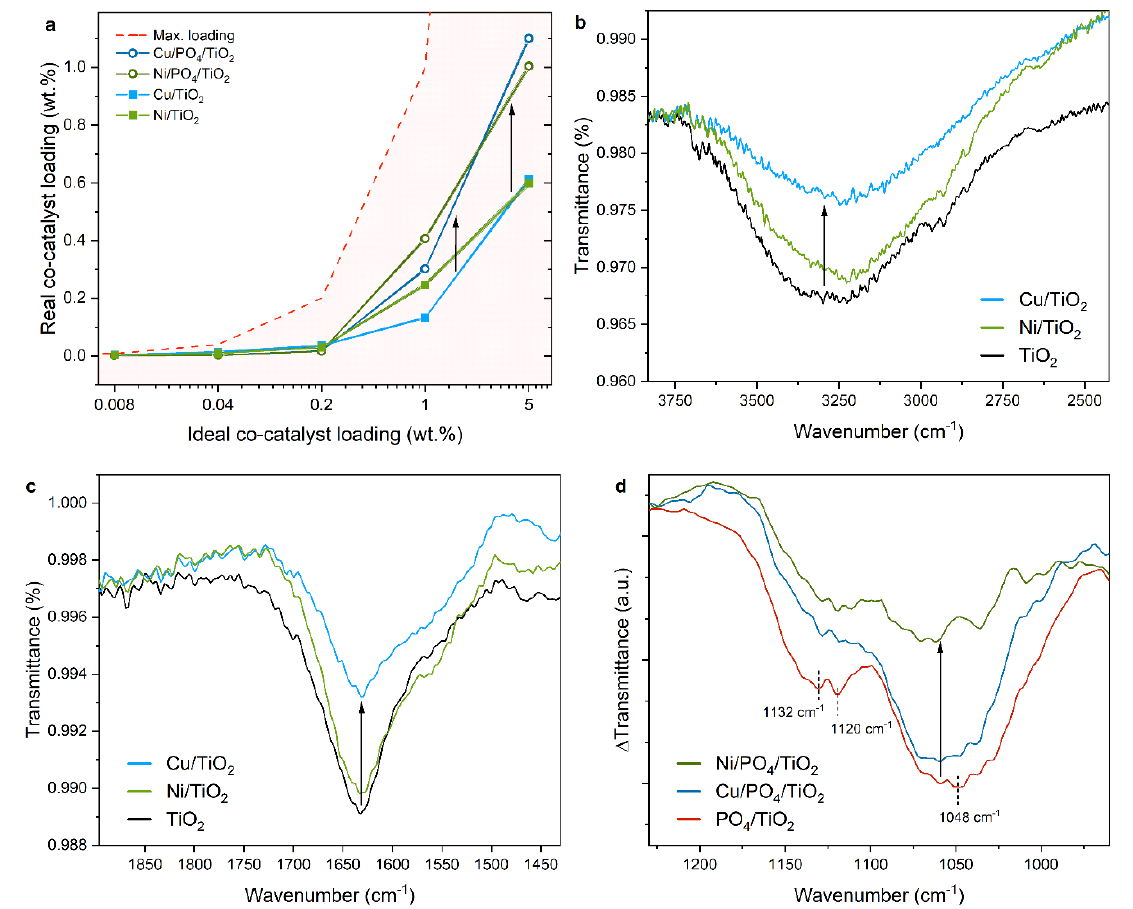
Figure 2. ( a ) Comparison of intended vs. real loadings of the different co-catalysts for Cu and Ni on bare TiO 2 and PO 4 /TiO 2 based on TXRF data and ATR-FTIR spectra: ( b ) OH-specific broad band at 3350 cm −1 for bare TiO 2 (black) 5/Cu/TiO 2 (blue) and 5/Ni/TiO 2 (green), ( c ) OH-specific mode at 1634 cm −1 for bare TiO 2 (black) 5/Cu/TiO 2 (blue) and 5/Ni/TiO 2 (green), and ( d ) PO 4 -specific modes for bare PO 4 /TiO 2 (red), 5/Cu/PO 4 /TiO 2 (blue) and 5/Ni/PO 4 /TiO 2 (green), the spectra in d are obtained by subtracting FTIR data of TiO 2 (Δ Transmittance in a.u. = arbitrary units). Table 1. Summary data of the achieved real loadings, determined through TXRF for Cu (above) and Ni (below) and both TiO 2 and PO 4 /TiO 2 support series.